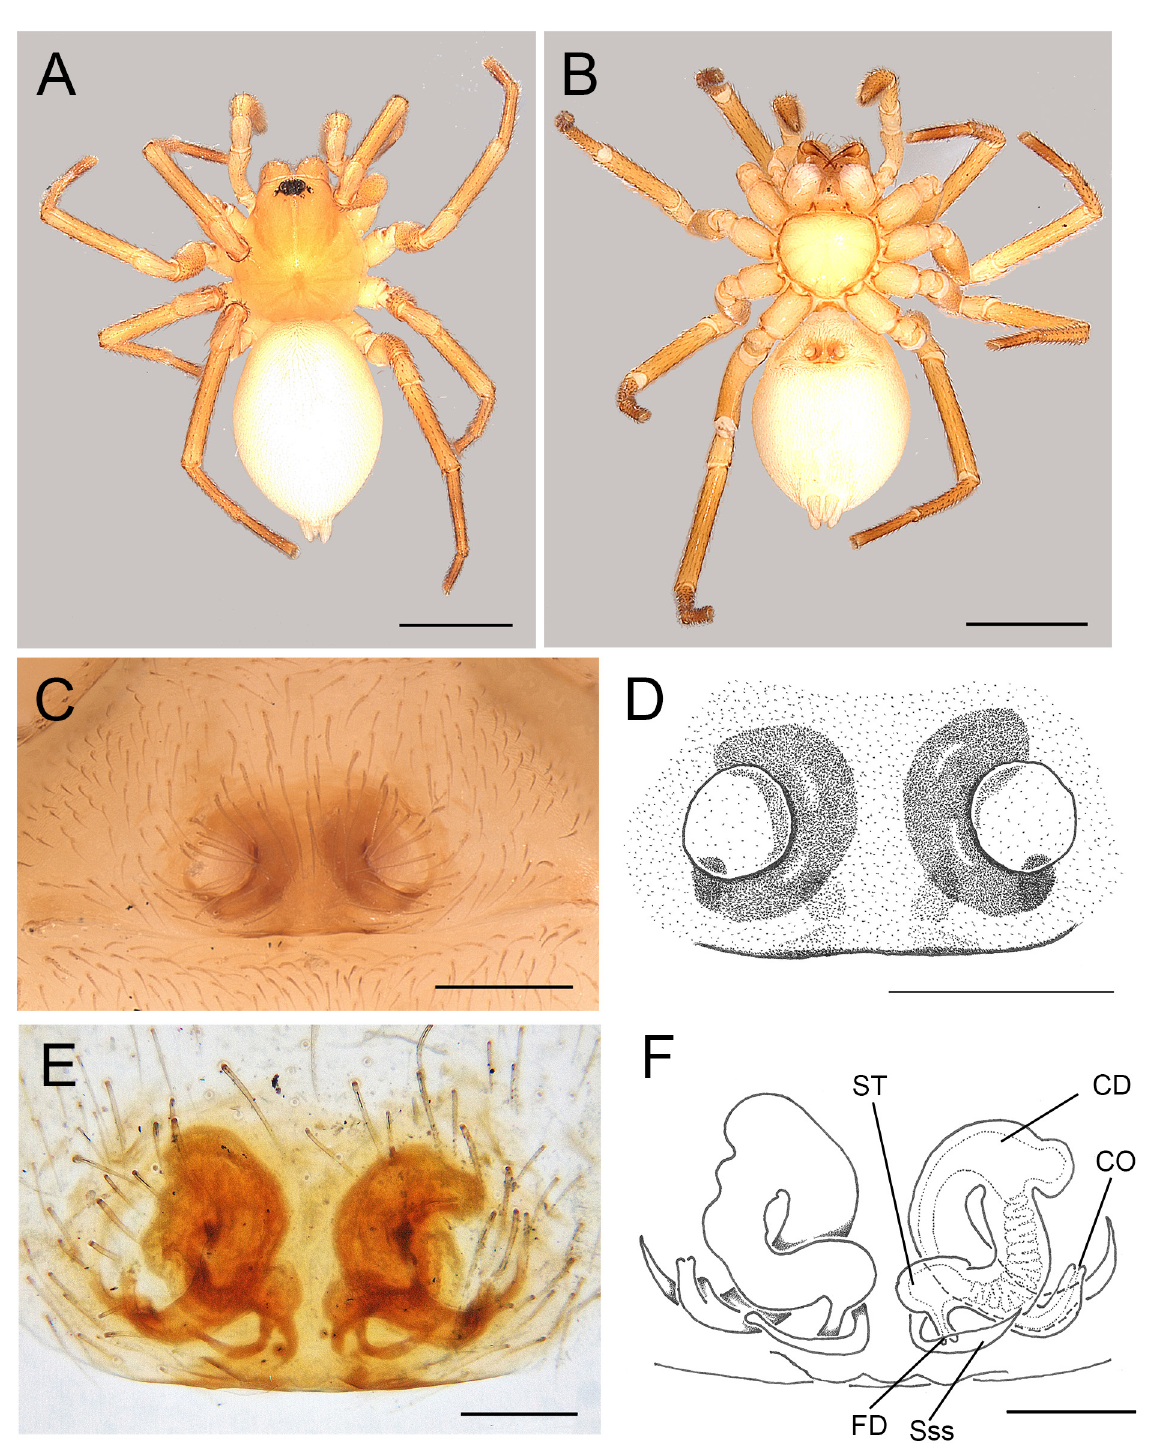
Fig. 9. Andromma anacardium sp. nov., ♀, holotype (BE_RMCA_ARA.Ara 90890). A . Habitus, dorsal view. B . Same, ventral view. C–D . Epigyne, ventral view. E–F . Epigyne, cleared, dorsal view. Abbreviations: CD = copulatory duct; CO = copulatory opening; FD = fertilisation duct; Sss = sickle shaped sclerites; ST = spermatheca. Scale bars: A–B = 1 mm; C–D = 0.2 mm; E–F =